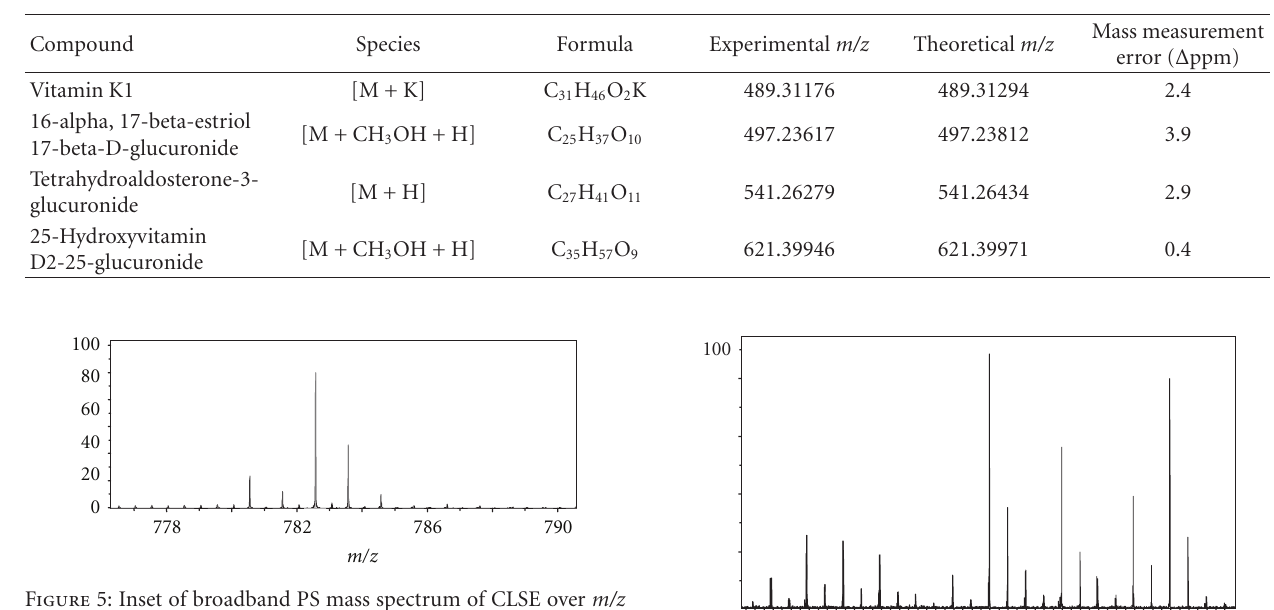
Table 5: Compounds identified using paper spray mass spectrometry on urine sample from 44-year-old volunteer. The urine mass spectrum was obtained with excitation and detection frequency range of 1.5 MHz.